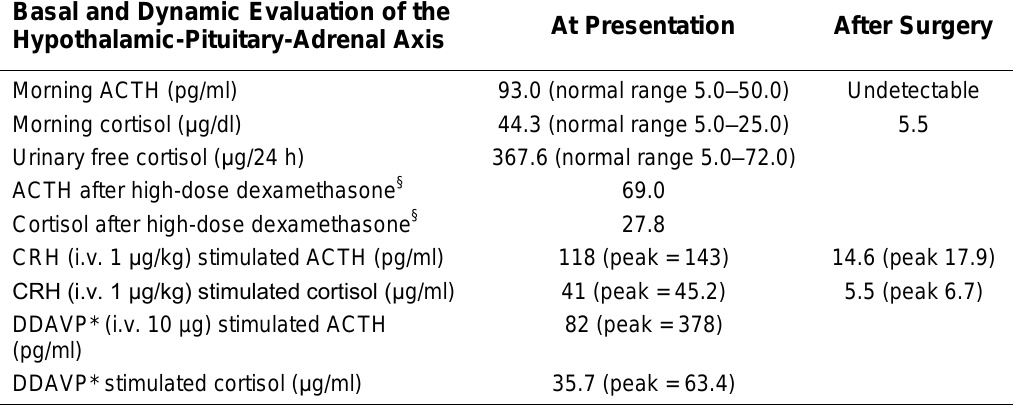
Endocrine Evaluation at Presentation and after First Surgery Basal and Dynamic Evaluation of the